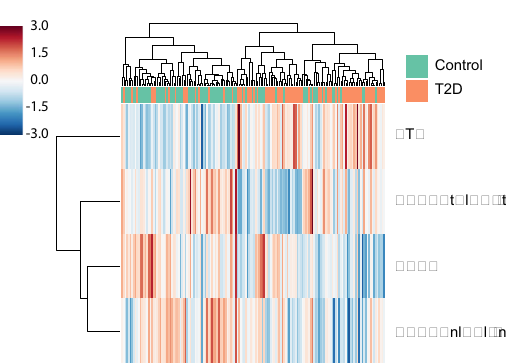
Figure 5. The relative abundance of biomarkers is shown as a heatmap. The color bar shows the abundance z-scores. Hierarchical clustering was applied to the validated biomarkers and cohort samples. The set of biomarkers are clustered into groups that are more or less abundant in the type 2 diabetes (T2D) group. The compounds at the top were found to be less abundant in T2D urine samples, while the compounds at the bottom are enriched in T2D urine